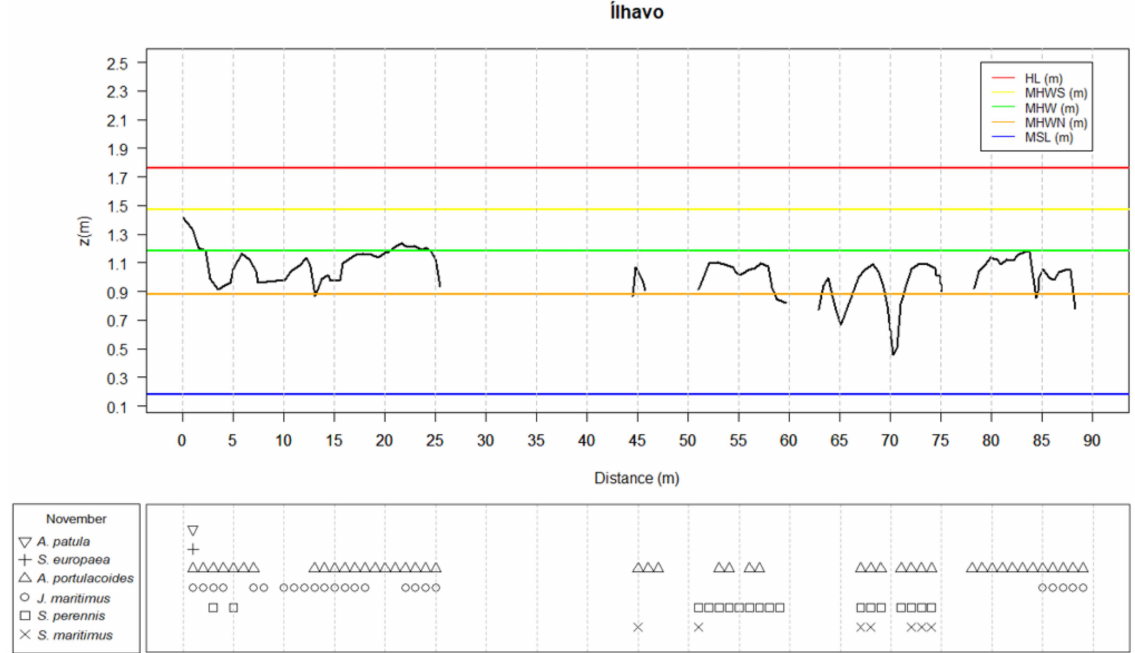
Figure 4. Topographic profile of Í lhavo’s salt marsh transect ranging from its upper limit at land to its lower border near water (black line) and its respective tidal levels, along with the vegetation distribution for November through the transect length. The gaps in the topographic profile illustrate the presence of either creeks or ditches without